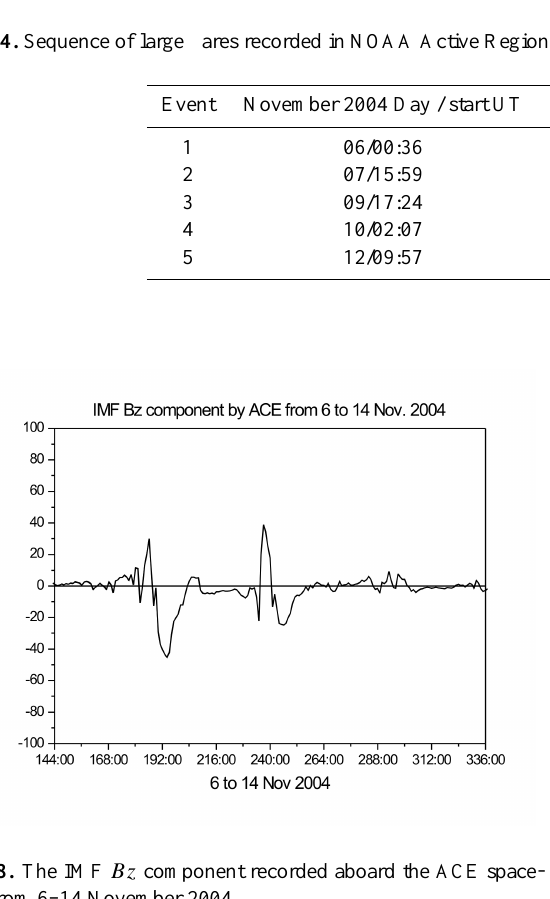
Fig. 18. The IMF Bz component recorded aboard the ACE space- craft from 6–14 November